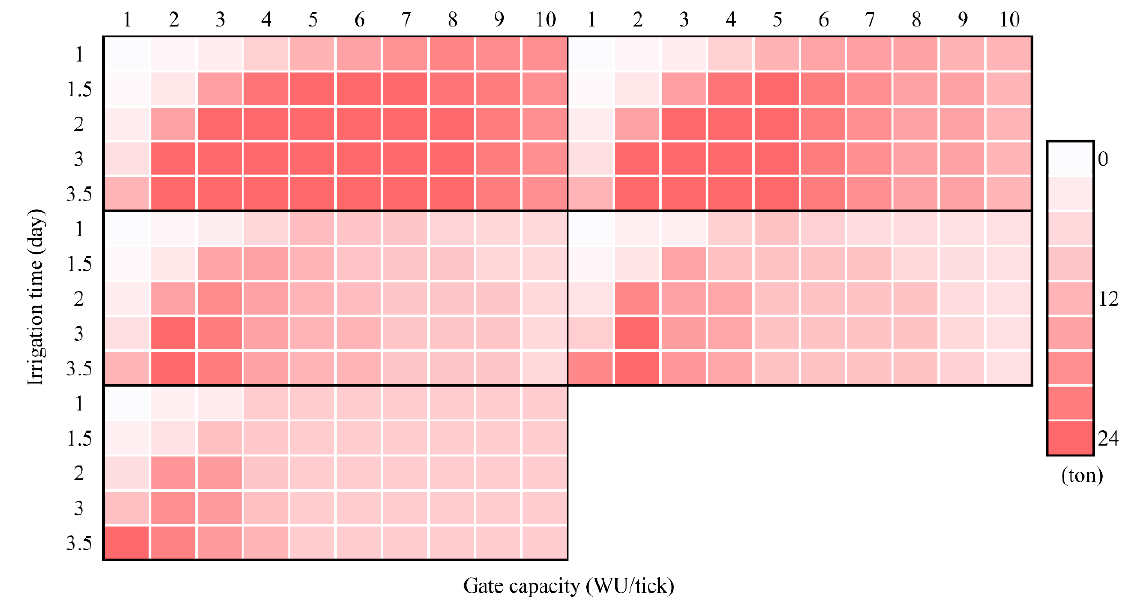
Figure 7. Yields per canal with insufficient water and Time Control (canal discharge of upper left, upper right, middle left, middle right, and low at 60, 40, 20, 10, and 5 WU/tick, respectively).